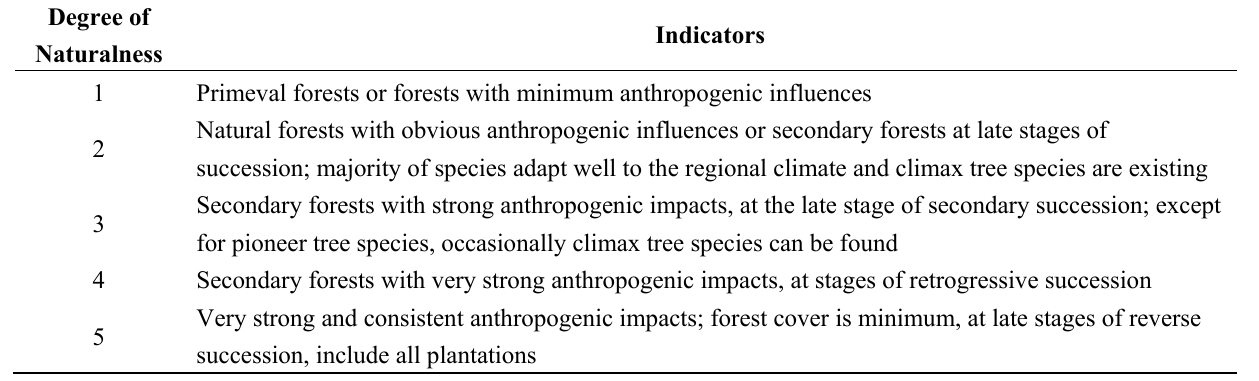
Table 4. Criteria for judging degrees of naturalness for forests in China